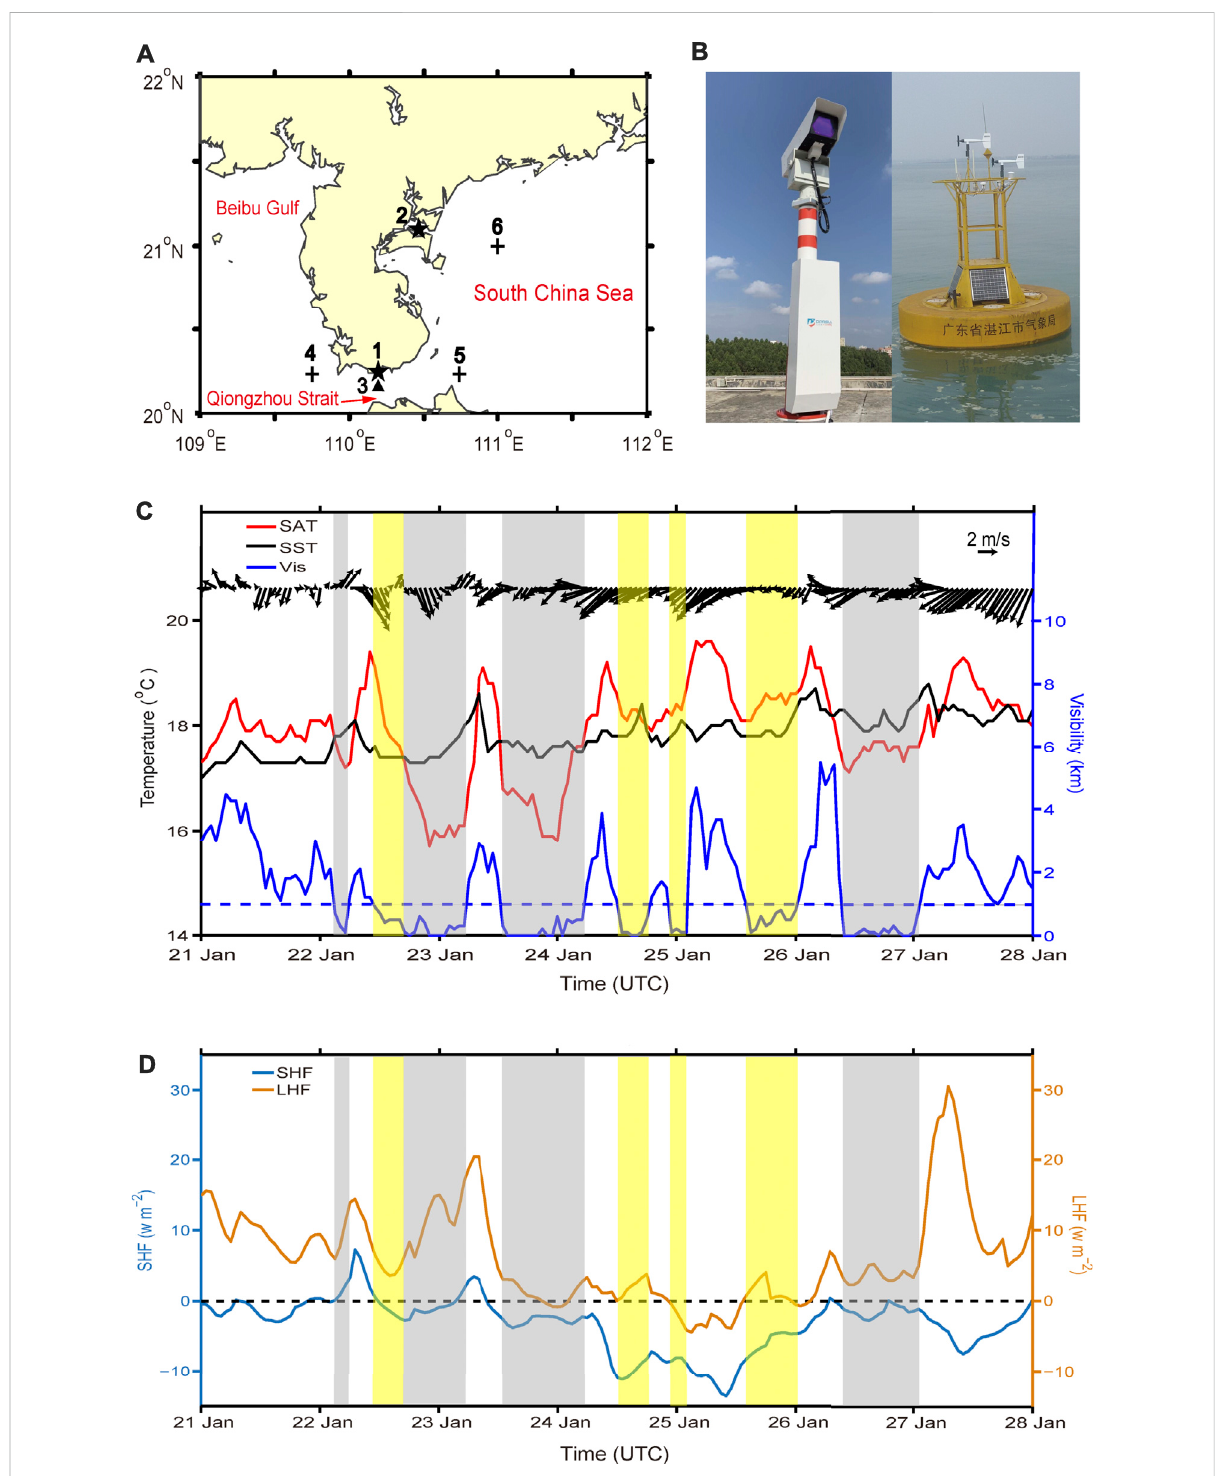
FIGURE 1 Overview of stations, instruments, and data. (A) Locations of 1) Xuwen harbor, 2) Zhanjiang harbor, 3) buoy, 4) — 5) Selected points to calculate the average heat fl ux data for Xuwen. 6) Selected point to represent the heat fl ux data for Zhanjiang. (B) Monitoring instruments. Left: visibility lidar. Right: buoy. Photo courtesy of Xinxin Zhang. (C) Wind vector, surface air temperature (SAT), sea surface temperature (SST), and visibility at Xuwen harbor for the 202101 fog event. The wind vector, SAT and SST from 3 m buoy data and the visibility from Xuwen station. Yellow bands indicate warm advectionfog, gray bands indicate cold. The adjacent yellow – gray band at23 January is classi fi ed as abnormal “ A ” in Table 3. (D) Sensible heat fl ux (SHF) and latent heat fl ux (LHF) at Xuwen based on ERA5